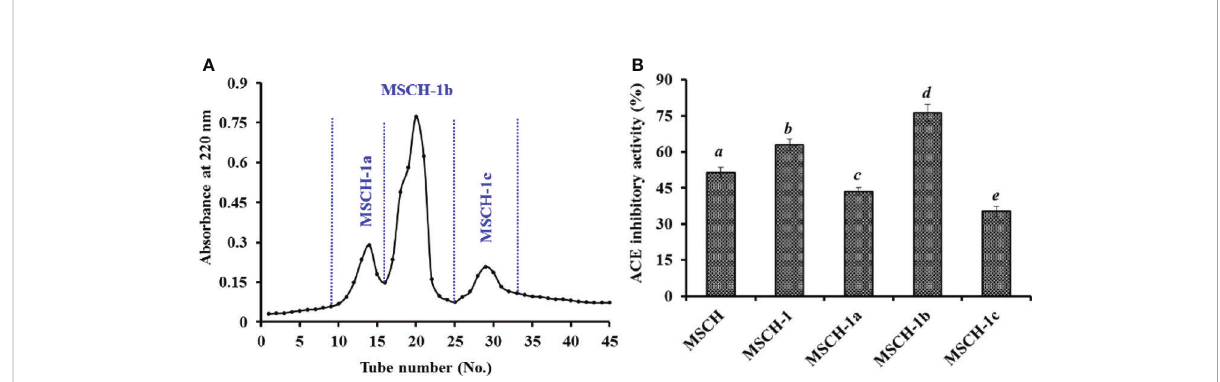
FIGURE 2 Chromatogram pro fi les of MSCH-1 isolated by Sephadex G-25 (A) and ACEi activity of prepared subfractions (MSCH-1a to MSCH-1c) from MSCH-I at 3.0 mg/mL (B) . All values are means ± SD (n = 3). a-e Same letters indicated no signi fi cant difference ( p <